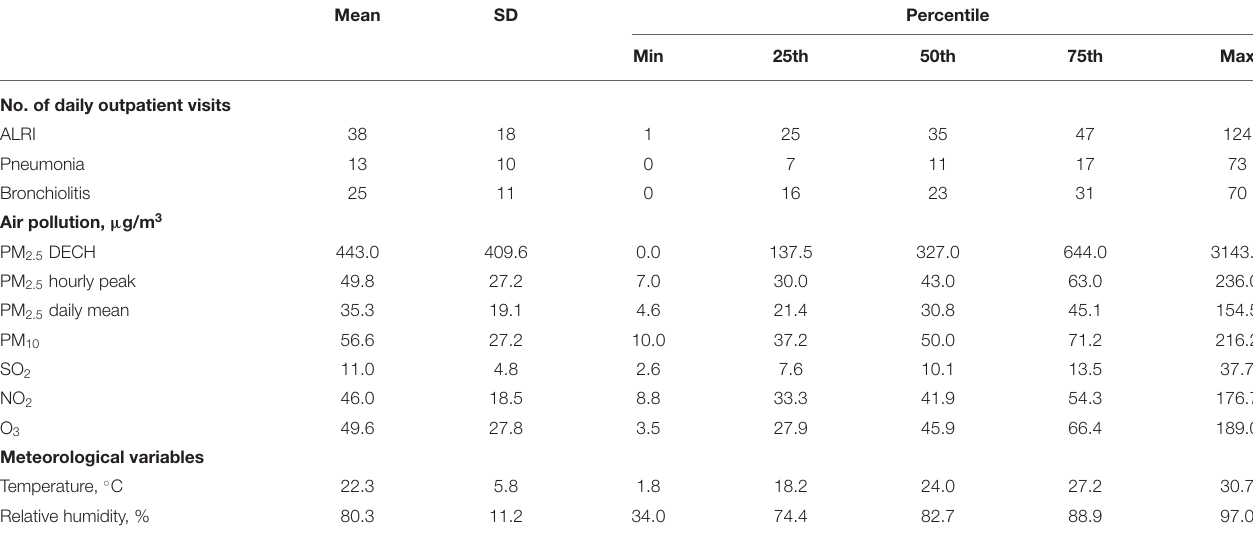
TABLE 1 | Summary statistics of acute lower respiratory infections outpatient visits, air pollutants, and meteorological variables.